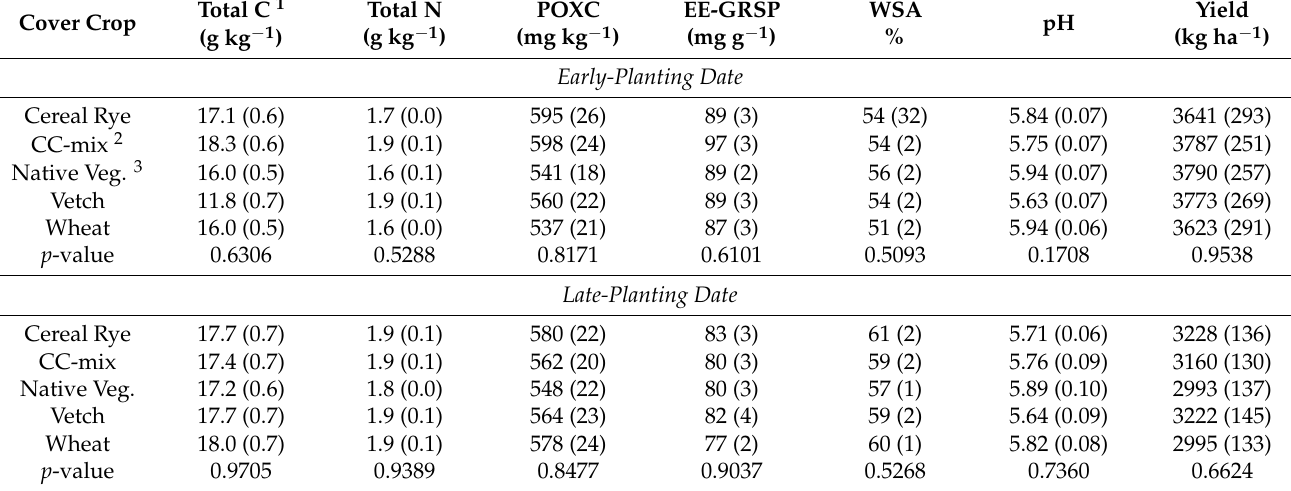
Table 6. Main effects of cover crop on mean soil total carbon (C), total nitrogen (N), permanganate oxidizable carbon (POXC), easily extractable glomalin-related soil protein (EE-GRSP), water-stable aggregate (WSA), soil pH and soybean yield with p -value at early and late planting dates.